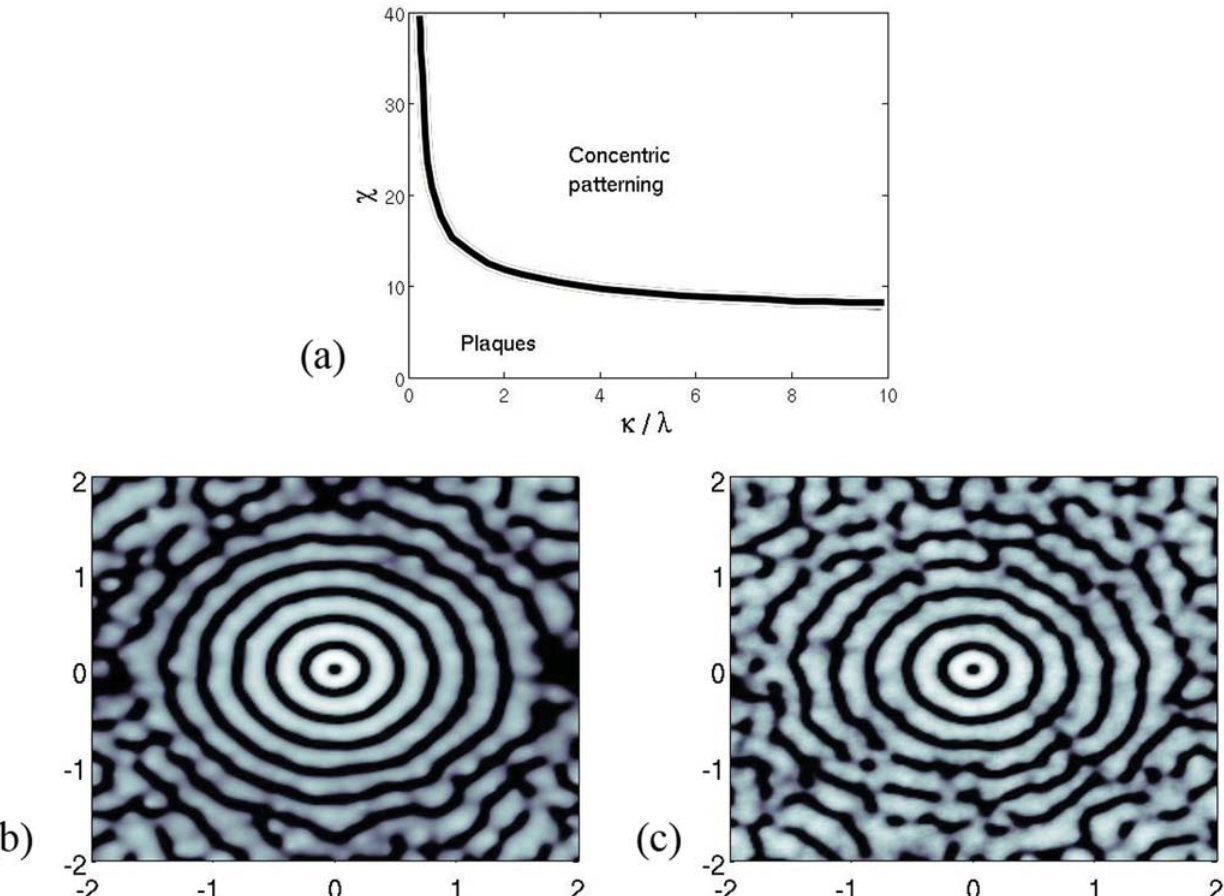
Figure 5. (a) Bifurcation diagram for fixed reduced parameter e˜ =0,1. Only two alternative patterns arise: concentric rings or plaques apparition. (b) Imposed white noise perturbation with relative standard deviation s =0,2 to the chemical diffusion coefficient e˜ =0,2. Other parameters are x˜ =25 and k / l =5. (c) White noise perturbation with relative standard deviation s =0,1 to the damaging factor k / l =5. We set e˜ =0,2 and x˜ =25. Destroyed oligodendrocytes are figured in black. The damaging factor is more sensible to perturbation that the chemical diffusion coefficient; increasing the standard deviation breaks the symmetry of the pattern, except around the origin. Anastomoses are noted in (c) far from the regions affected by the boundary